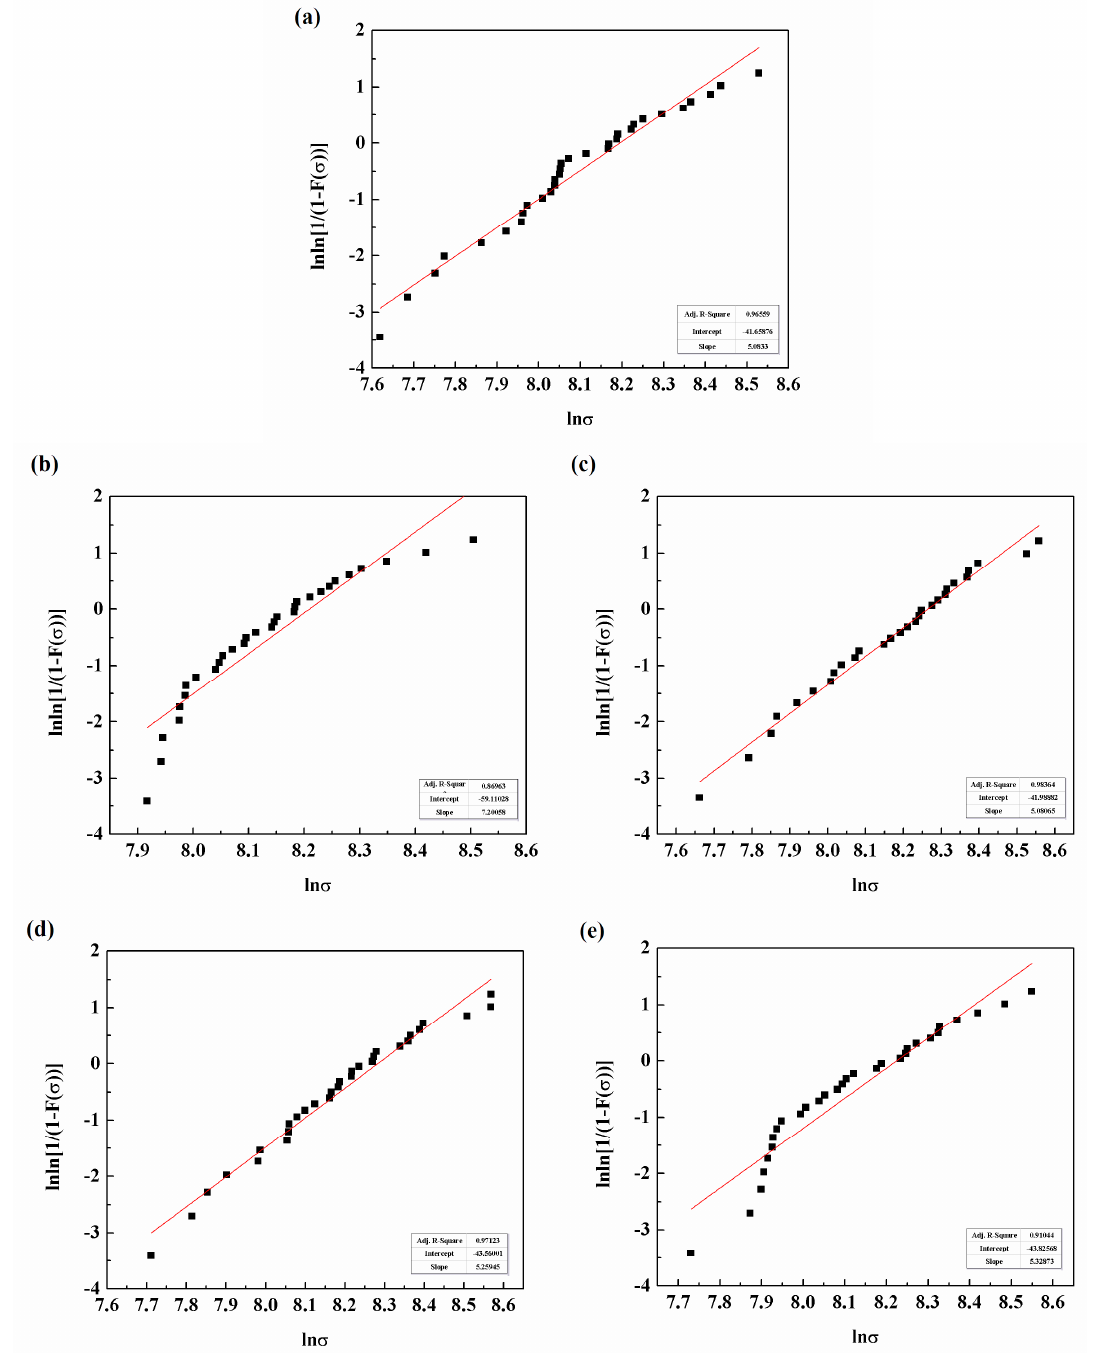
Figure 11. Weibull distribution of monofilament fibre tensile strength of unsized CFs and sized CFs: ( a ) unsized; ( b ) 7500; ( c ) 11,000; ( d ) 15,000; and ( e ) 17,000.